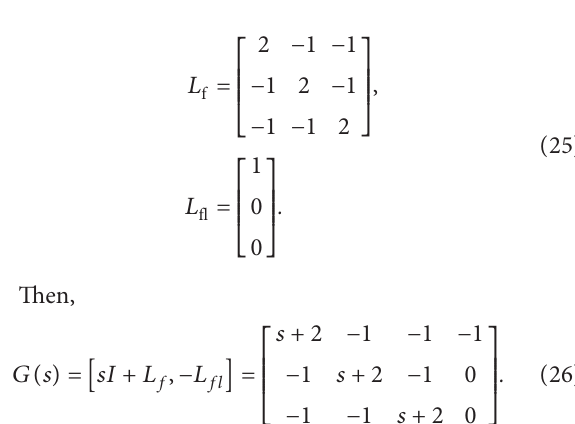
Figure 10: A triangle